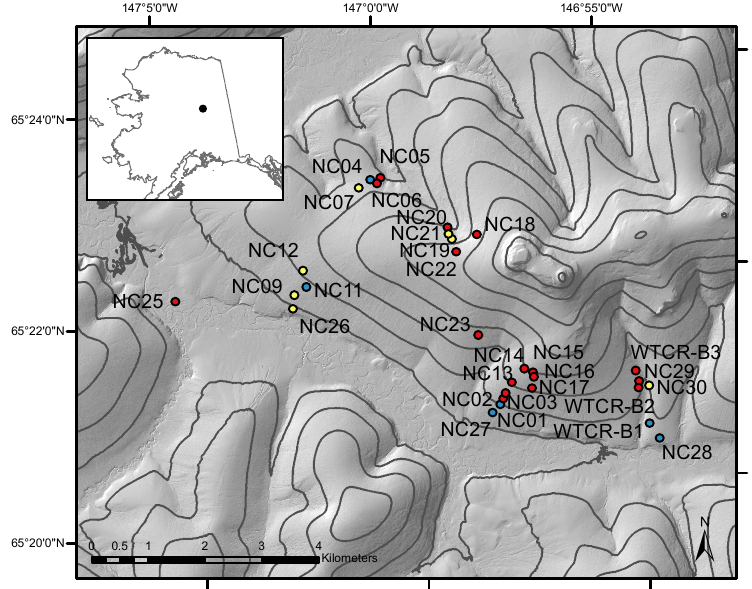
Figure 1. Map of study area and 30 field sites in the White Mountains National Recreation Area in interior Alaska. Symbols are colored to represent soil temperature at 1 m depth (blue: ≤ 0.00 ◦ C; yellow: 0.01–2.00 ◦ C; red: ≥ 2.01 ◦ C). Contour lines (50-m) are overlain on a 2.5-m